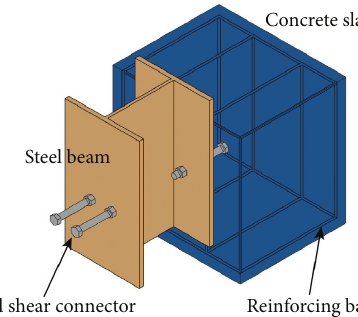
Figure 2: The components of the